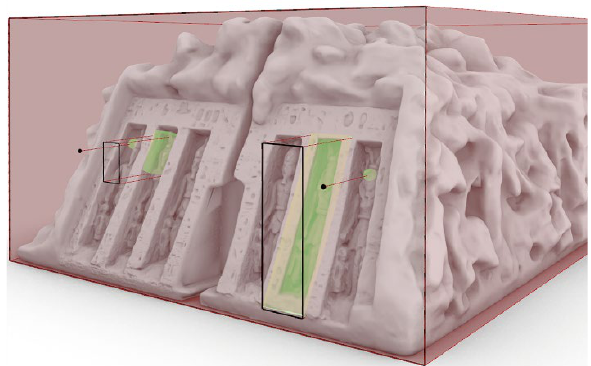
Figure 12. Remapped geometry from the picture, then projected on 3D model